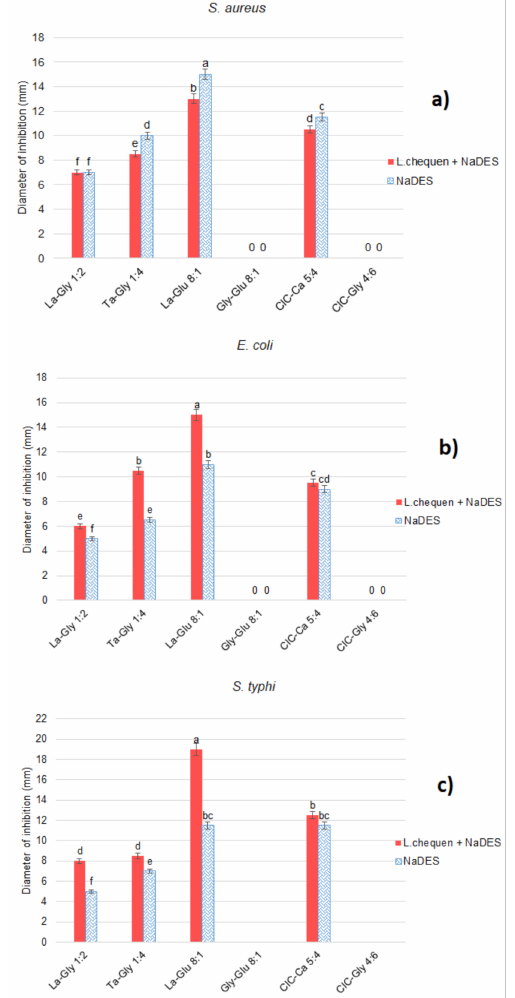
Figure 1. Antibacterial capacity of extracts of L. chequen obtained with NADES listed in Table 2 against ( a ) S. aureus , ( b ) E. coli , and ( c ) S. typhi (different letters in columns indicate significant difference (Tukey’s HSD, p <